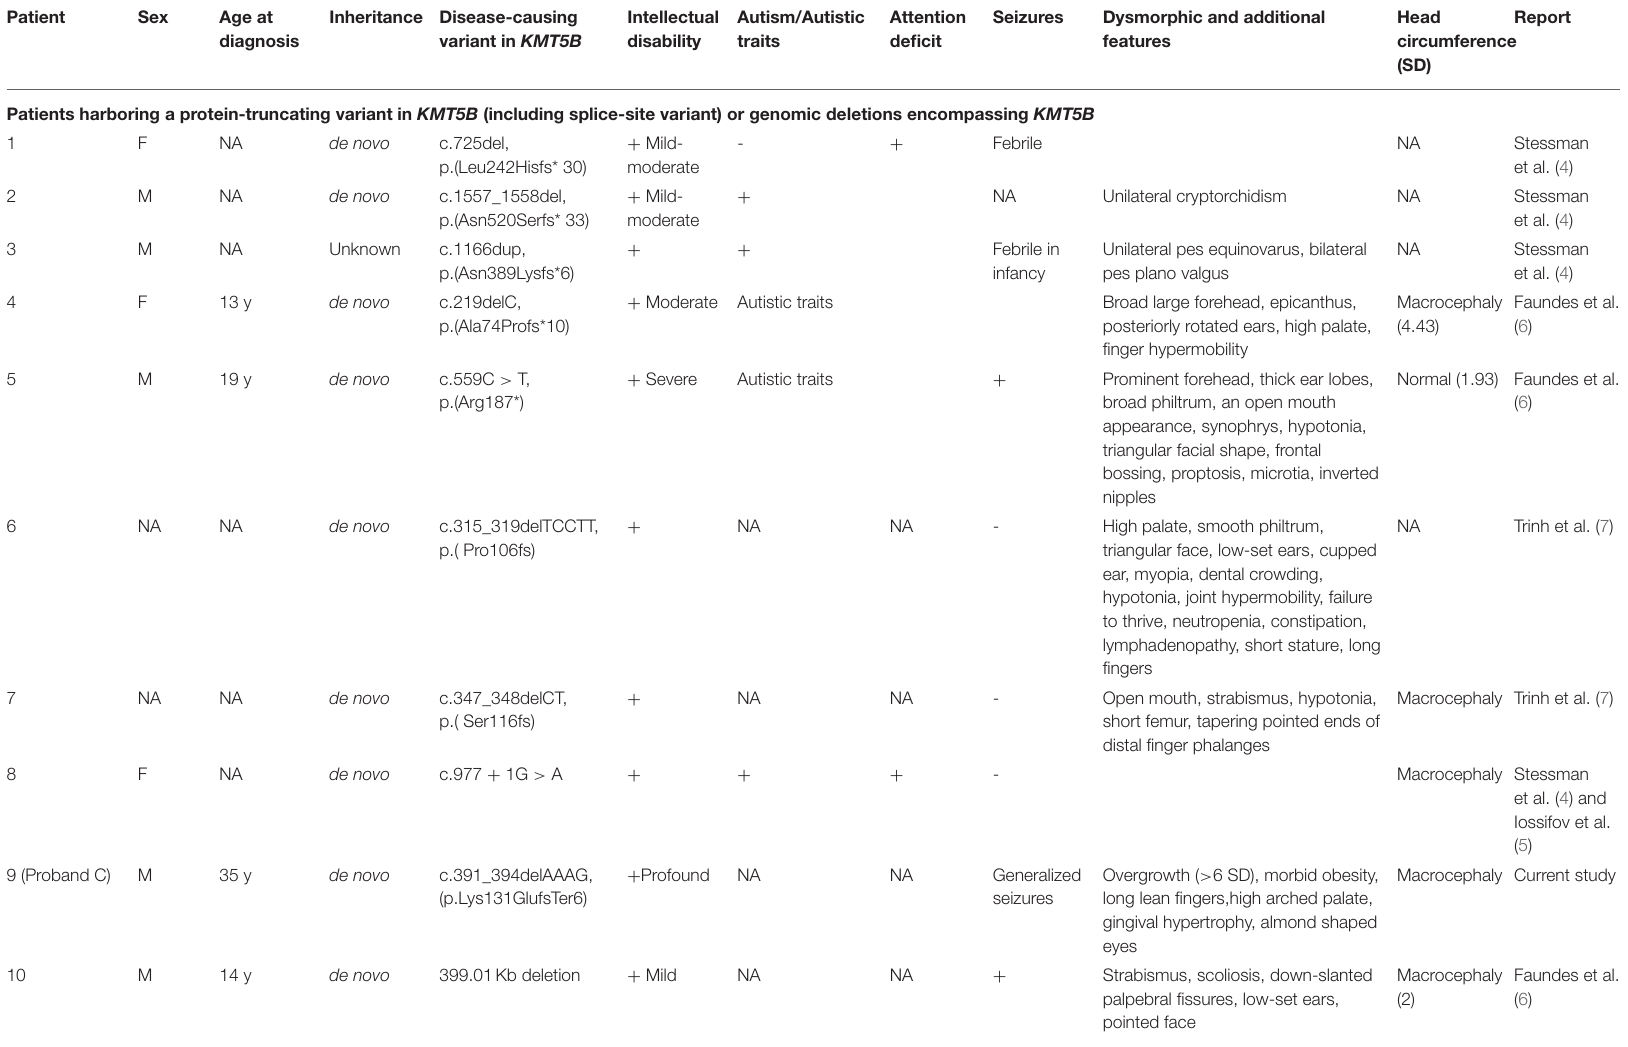
TABLE 1 | Clinical and molecular characteristics of individuals harboring disease-causing variants in KMT5B or deletions encompassing KMT5B . Patient Sex Age at